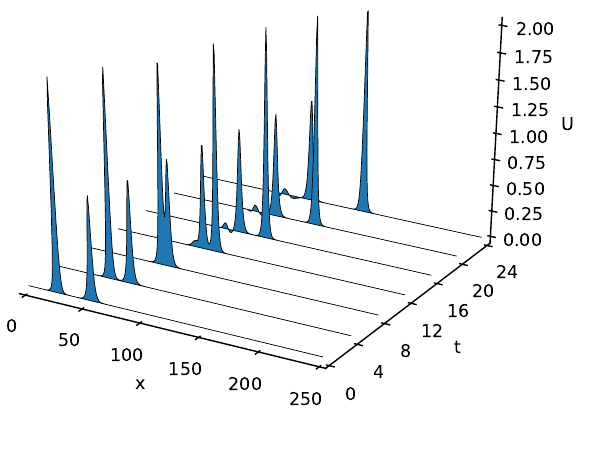
Figure 4. Interaction of two solitary waves for N = 400, p = 2, c 1 = 4, c 2 = 1 , x 1 = 25 , x 2 = 55 , ∆ t = 0 . 025 , and µ = 1 at t = 0 , 4 , 8 , 12 , 16 , 20. Table 10. Comparison of the results for p = 3, c 1 = 48 / 5, c 2 = 6 / 5, x 1 = 20, x 2 = 50, ∆ t = 0 . 01, µ = 1 on 0 ≤ x ≤ 120 at different final